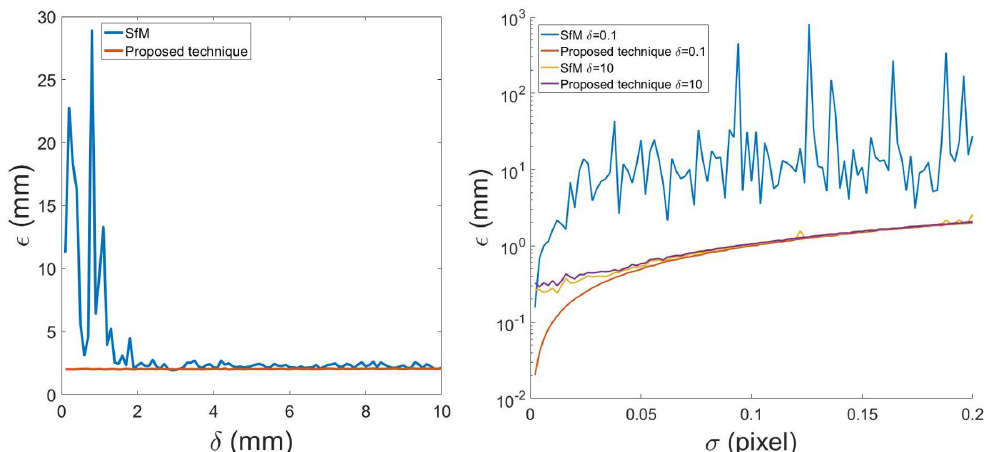
Figure 6. Left: 3D reconstruction error comparison between the proposed technique and traditional SfM when road unevenness δ is changing from 0 to 10 mm. Right: 3D reconstruction error comparison between the proposed technique and traditional SfM at different image noise σ while δ = 0.1 or 10